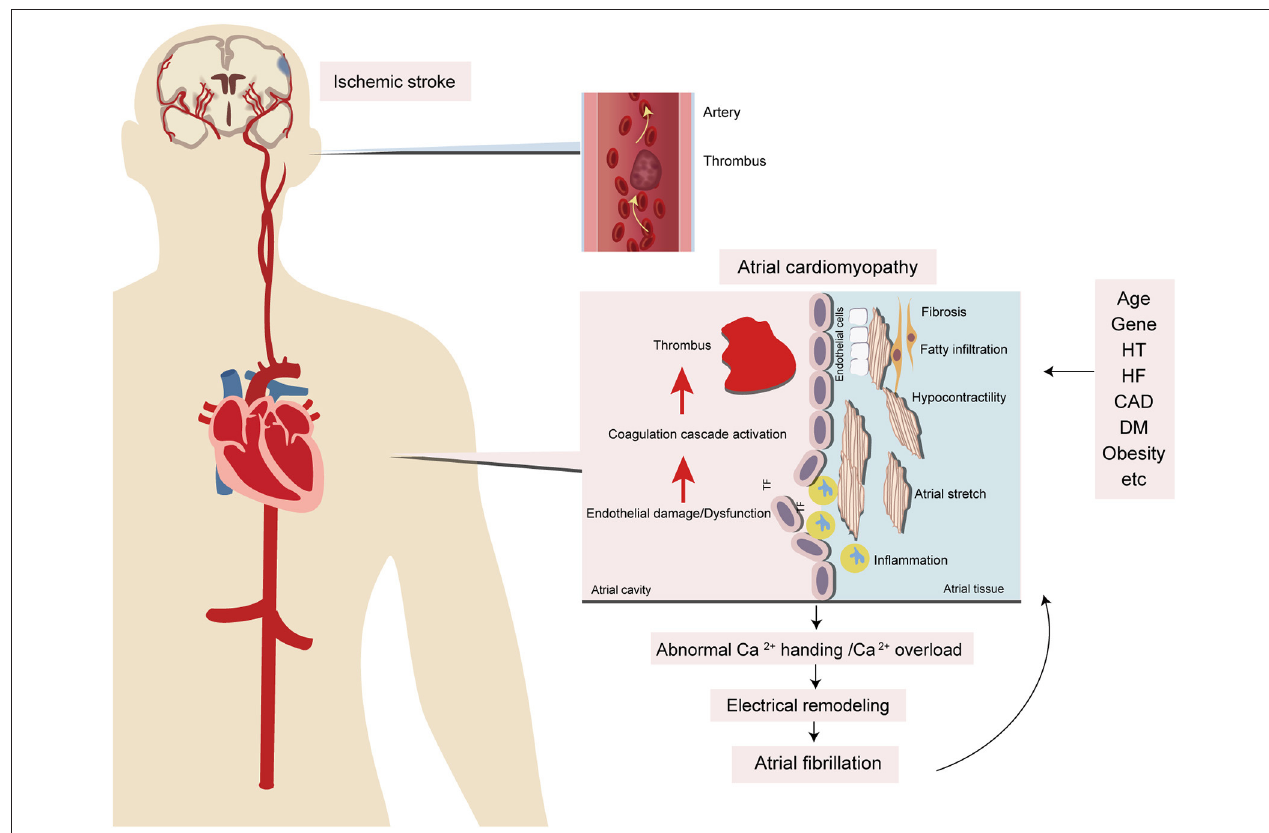
FIGURE 3 | Potential mechanisms of atrial cardiomyopathy and the relationship with stroke and AF. Several risk factors, including aging, hypertension, heart failure, diabetes, obesity, inflammation, and obstructive sleep apnea, contribute to atrial injury, like stretch and enlargement which leads to atrial fibrosis, endothelial cell dysfunction, and impaired myocyte function. Because of these dysfunctions, there are electrical and structural remodelings of the myocardium that contribute to thromboembolism and AF. HT, hypertension; HF, heart failure; CAD, coronary artery disease; DM, diabetic mellitus; TF, tissue